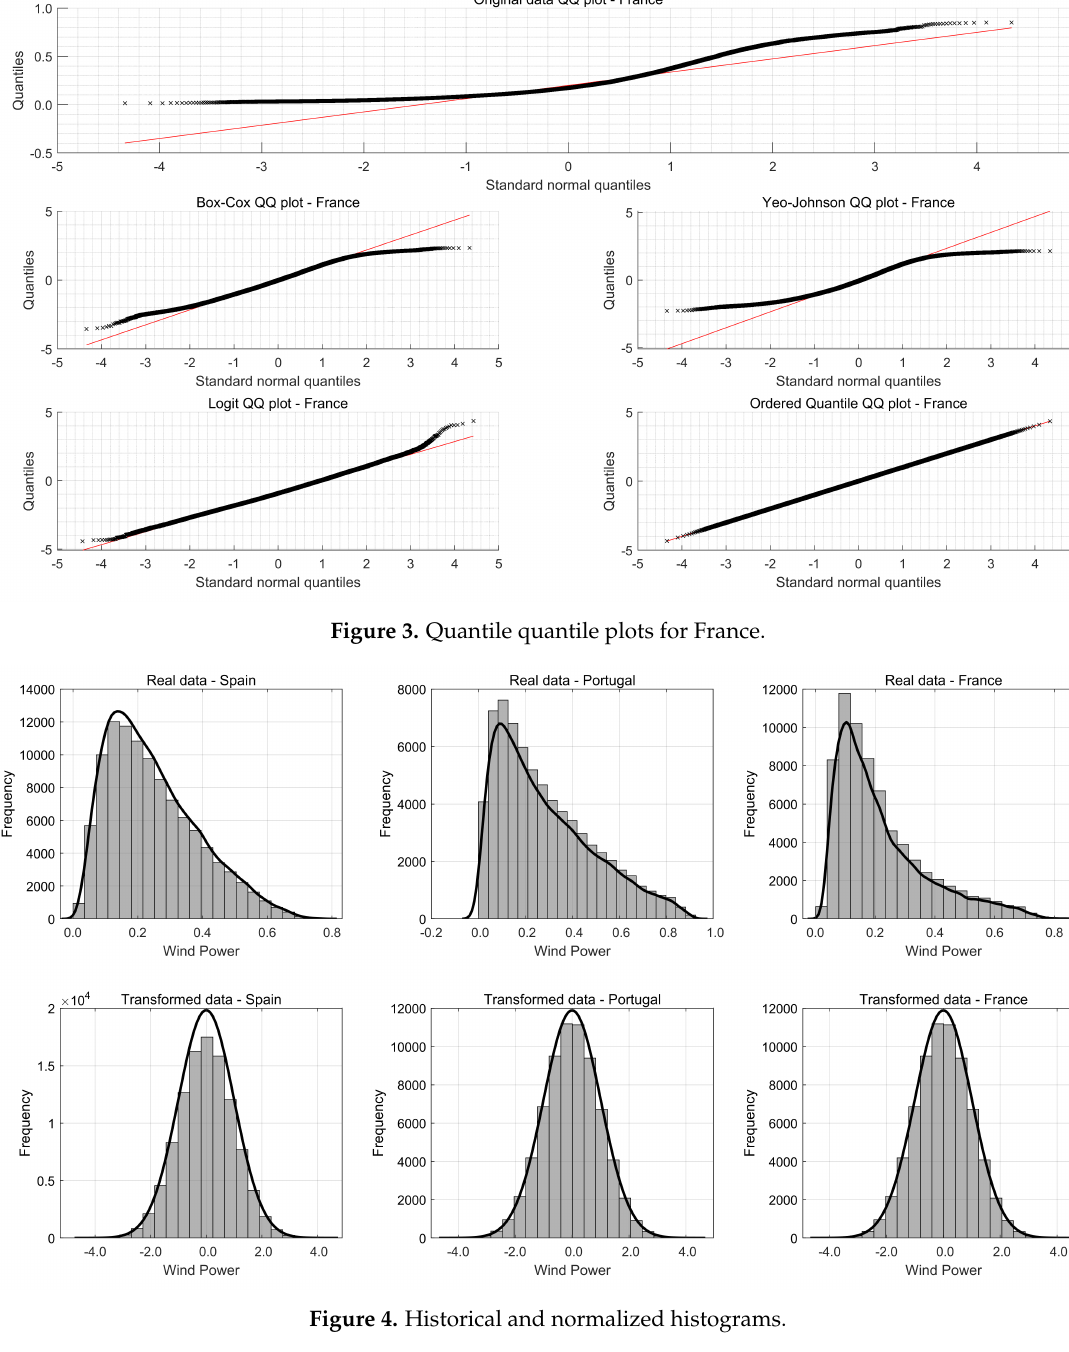
Figure 4. Historical and normalized